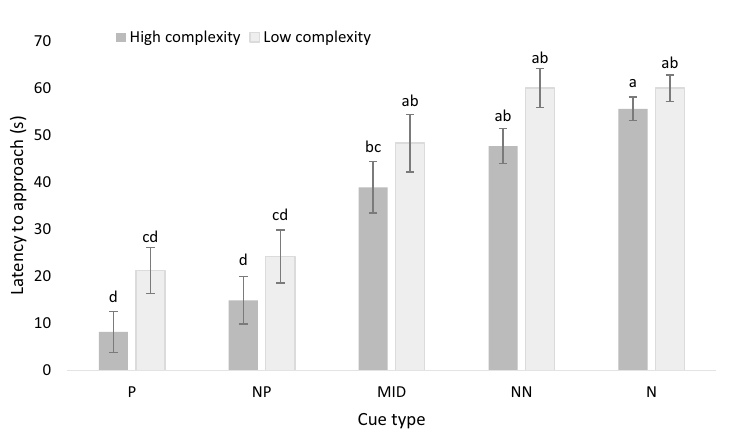
Figure 2. Mean (± SEM) latency to approach (s) all five cues (positive, P; near positive NP; middle, MID; near neutral, NN; and neutral, N) for birds from both high- and low-complexity pens in the judgement bias test for 4 rounds (n = 9). Means with different superscripts ( a–d ) differ at p <